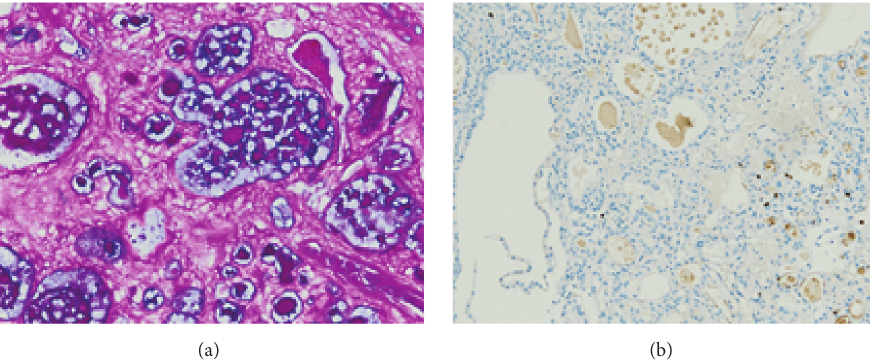
Figure 3: (a) Sinonasal tumour with luminal PAS-positive secretions, × 20. (b) Ki67 staining demonstrates a low mitotic index, × 10.